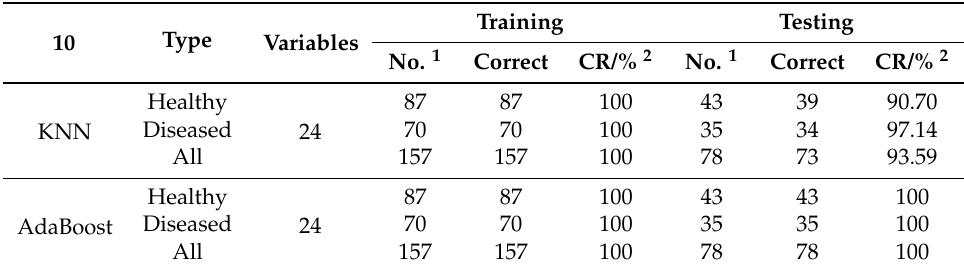
Table 5. Classification results based on HSV